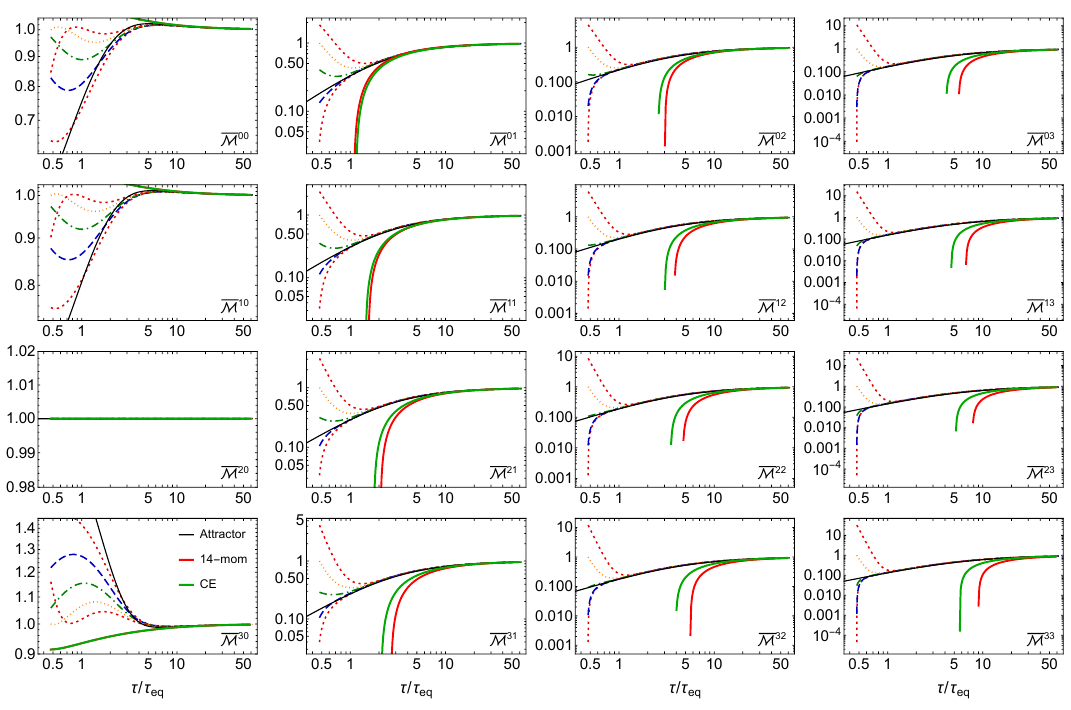
Figure 4 . Scaled moments M nl as a function of rescaled time for the case m = 1 GeV. Initial conditions and line styles are the same as in figure